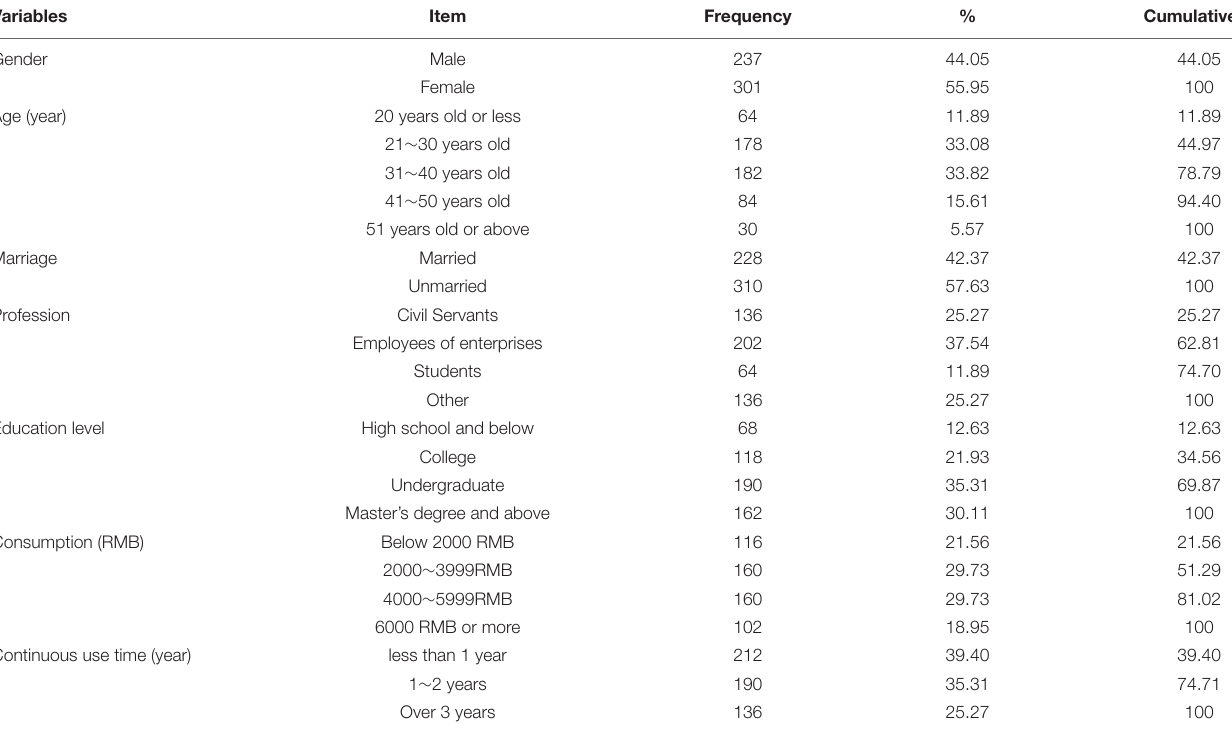
TABLE 1 | Descriptive statistical